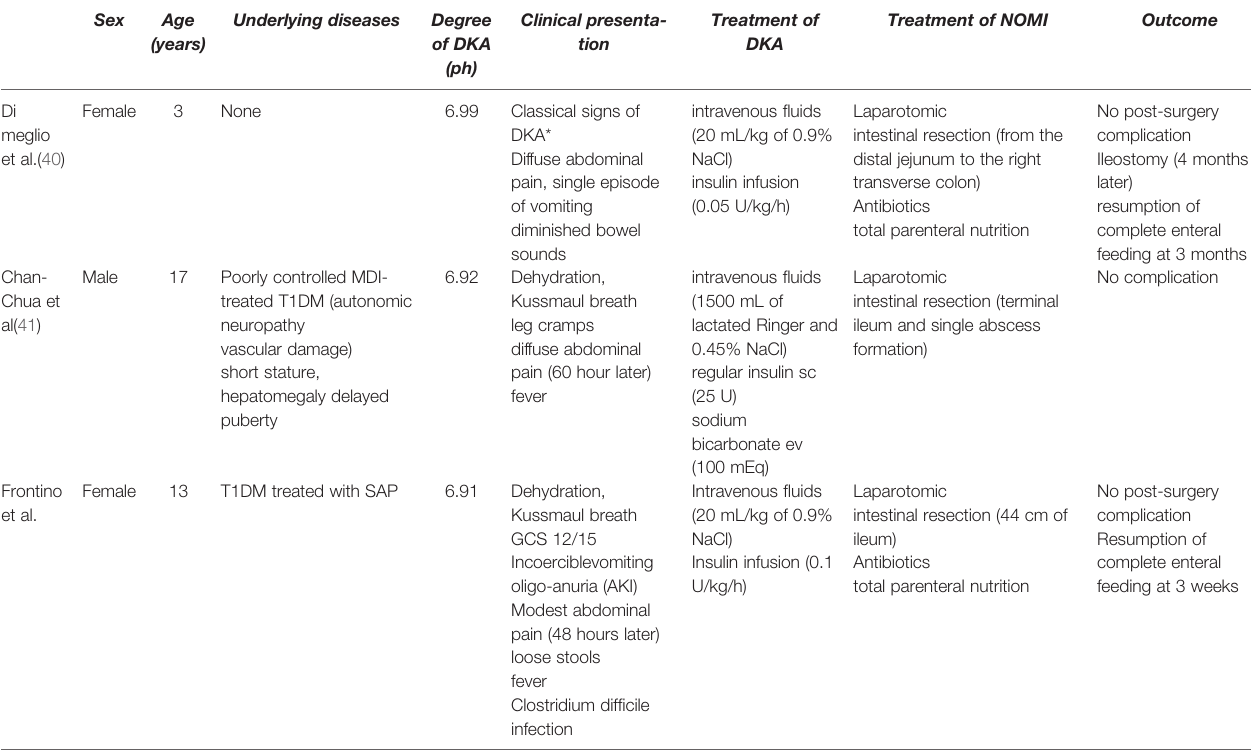
TABLE 2 | Summary of pediatric DKA-related NOMI in